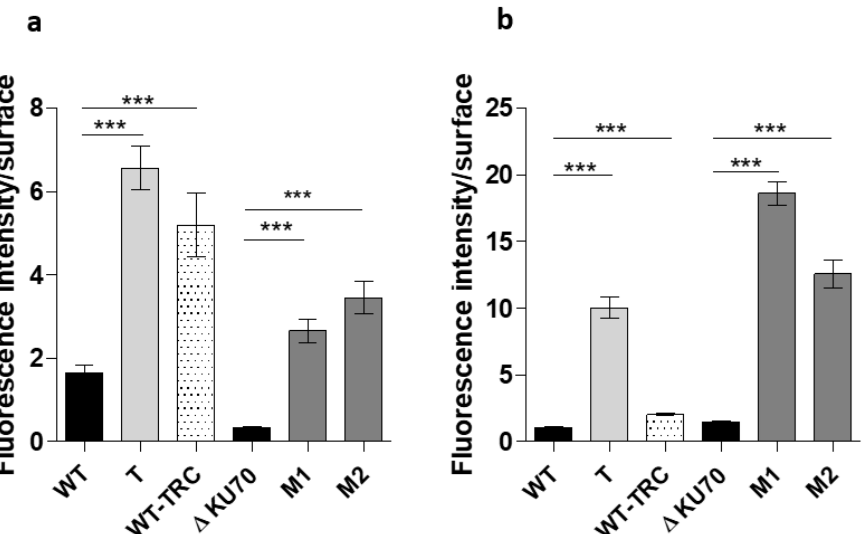
Figure 4. Analysis of the fluorescence labelling of conidia surface carbohydrates with FITC-conjugated lectins. ( a , b ) Fluorescence intensity of ( a ) ConA binding to mannosyl and glucosyl residues and ( b ) WGA binding to N-acetylglucosamine (NAG) residues on the surface of the conidia. Fluores- cence analysis was performed using ImageJ (Fiji) software from at least 200 conidia. The graph is representative of three independent experiments. Significant differences are indicated: *** p < 0.001 (Kruskall-Wallis test). T: transformant derived from the WT strain; M1 and M2: transformants derived from the Δ KU70 strain.